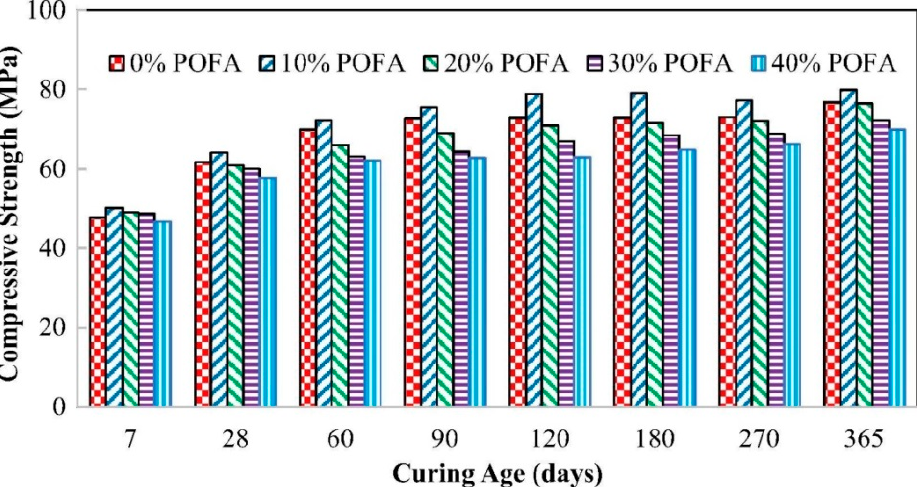
Figure 12. Relationship between compressive strength and POFA with different percentages at different ages [127]. Reprinted with permission from Elsevier [127]. Table 11. Compressive strength with different setting times.